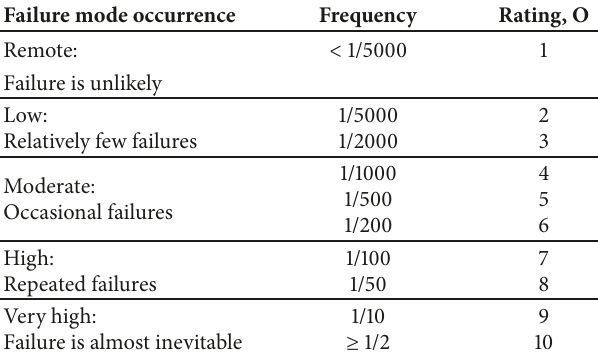
Table 3: Failure mode occurrence related to